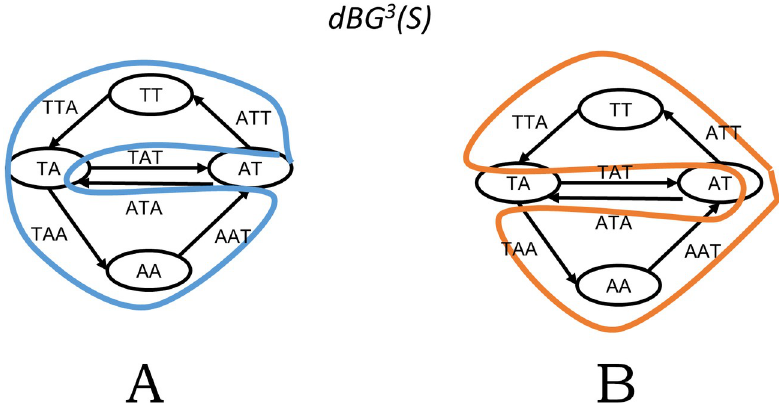
Fig 1. A worked out example for a set of reads R = {TATTA , TAATA} and k = 3 . Here, the set of all k-mers is S = sp k ( R ) = { TAT , ATT , TTA , TAA , AAT , ATA }. Panel A shows G 1 = dBG k ( S ) and one possible Eulerian cycle of G 1 (in blue). Panel B show the only other Eulerian cycle in G 1 (in orange). The genome reconstruction corresponding to the blue cycle is ATTAATAT and to the orange cycle is ATTATAAT (note that because the genome is circular, the last 2 characters of each string are equal to the first 2 characters).